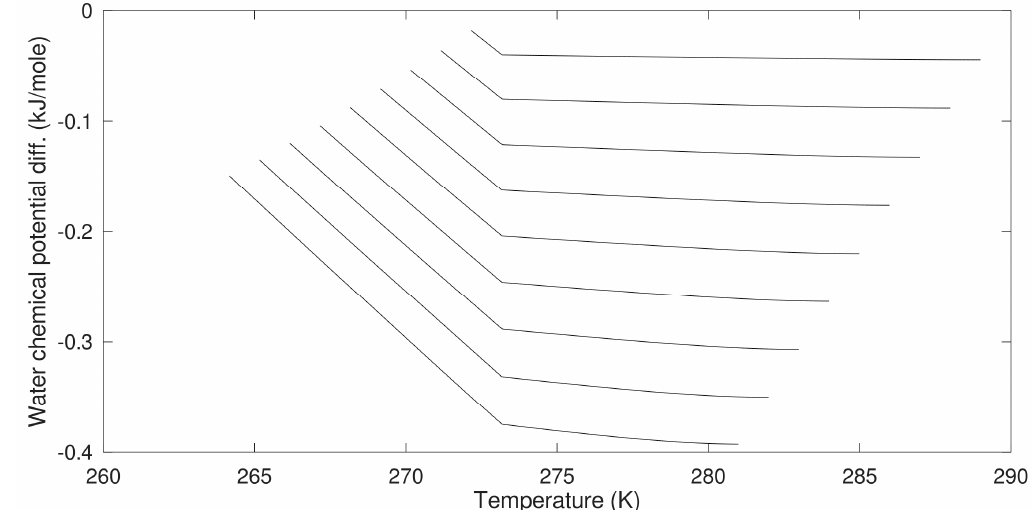
Figure 3. Chemical potential of water in hydrate minus chemical potential for water as liquid or ice, as function of various degrees if sub-cooling. Upper curve is for 1 °C sub-cooling, then 2 °C sub-cooling, then 3 °C sub-cooling, then 4 °C sub-cooling, then 5 °C sub-cooling, then 6 °C sub-cooling, then 7 °C sub-cooling, then 8 °C sub-cooling and lowest curve for 9 °C sub-cooling.